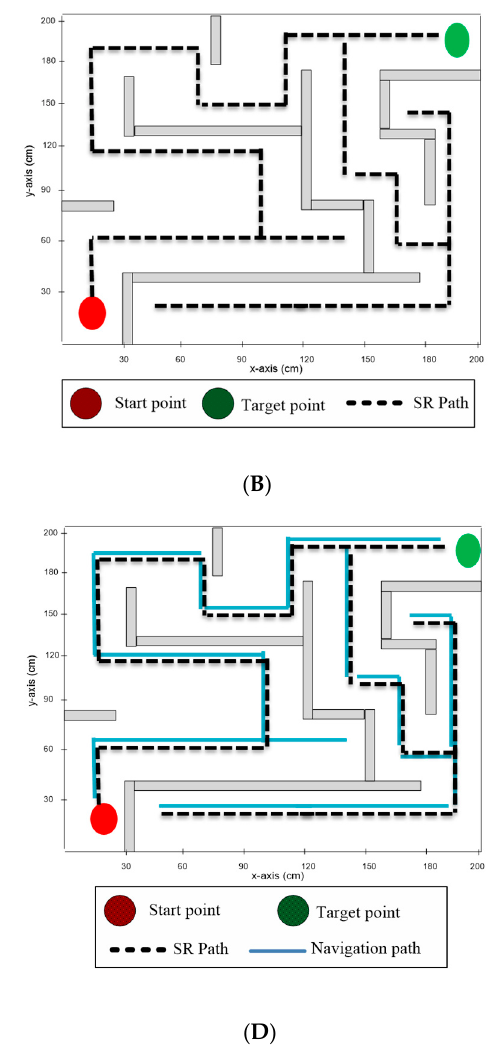
Figure 8. The route of the solver robot using 4 algorithms in testbed # 1. ( A ) Pledge algorithm; ( B ) right-hand algorithm; ( C ) left-hand algorithm; ( D ) MWFS.